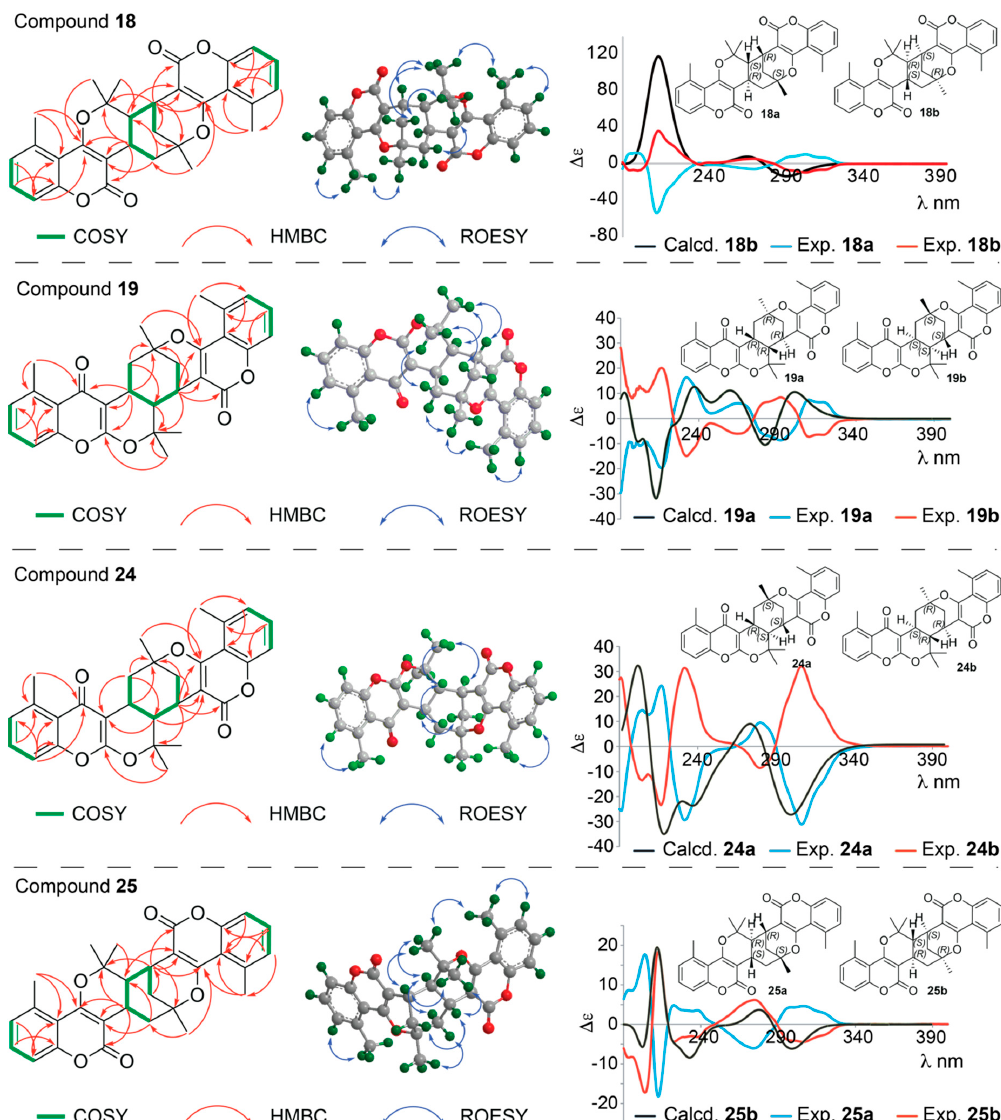
Figure 7. Left : Key COSY and HMBC correlations of 18 , 19 , 24 and 25 . Middle : Key ROESY correlations used to establish relative configuration of 18 , 19 , 24 and 25 . Right : Calculated ECD spectra of 18b , 19a , 24a and 25b and experimental ECD spectra of the enantiomers 18a / b , 19a / b , 24a / b and 25a / b . The enantiomeric structures of 18 , 19 , 24 and 25 are shown with absolute configuration of the stereocenters determined based on the ECD